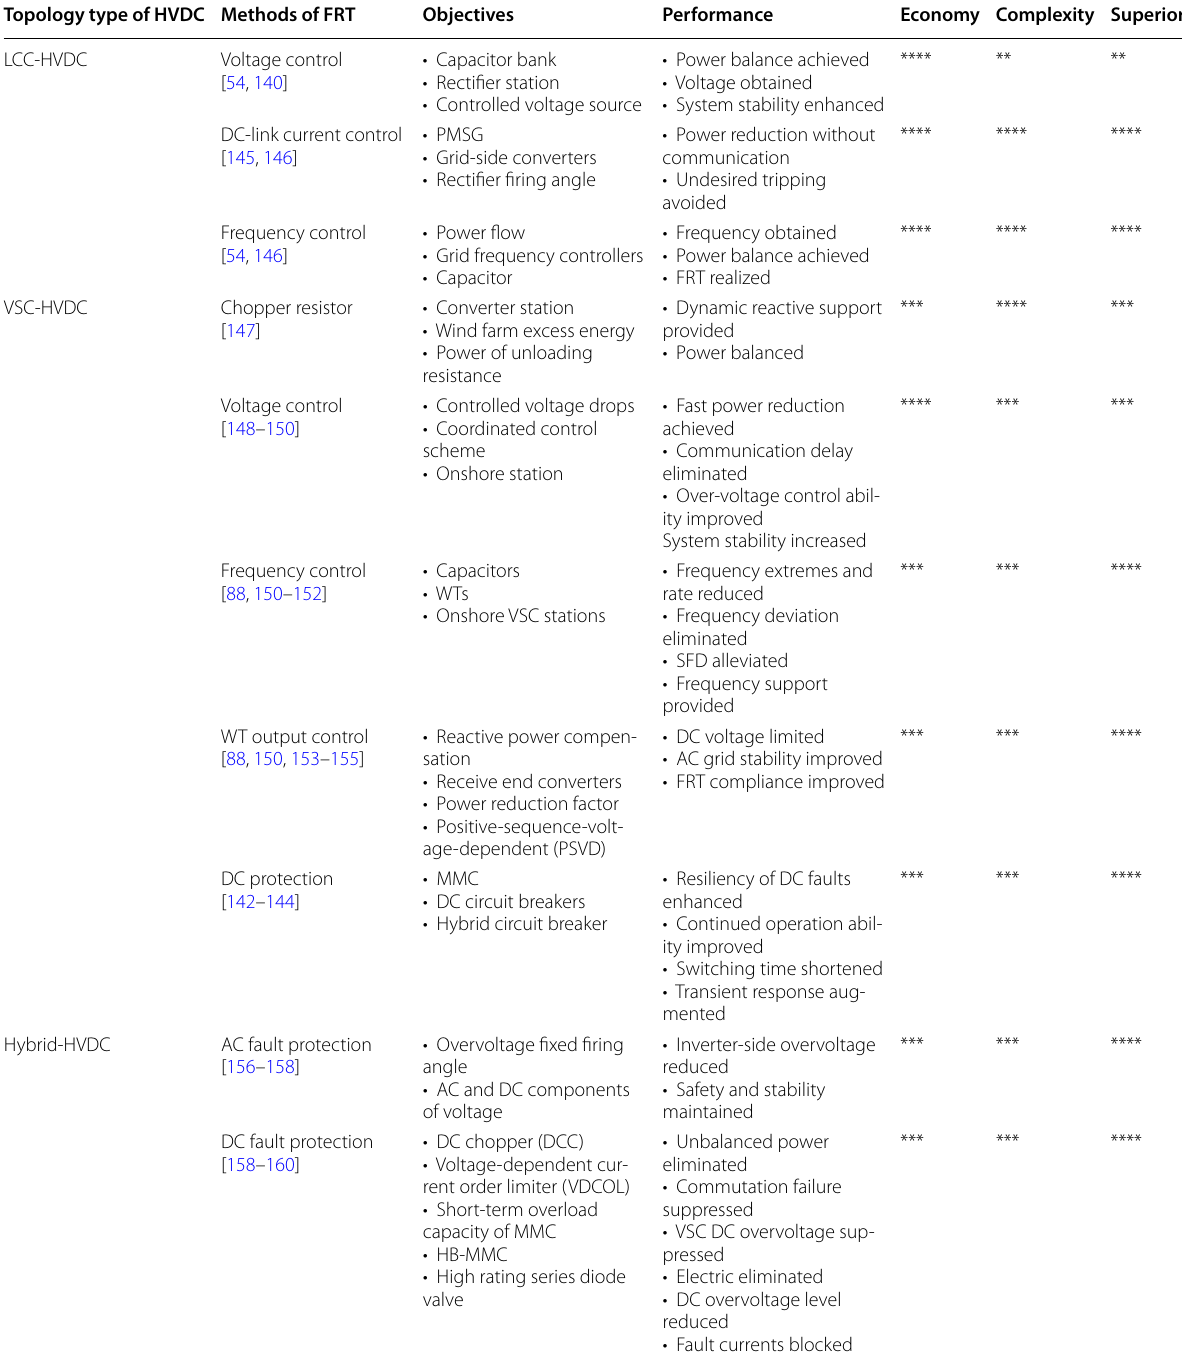
Table 9 FRT technologies of HVDC (four topologies) Topology type of HVDC Methods of